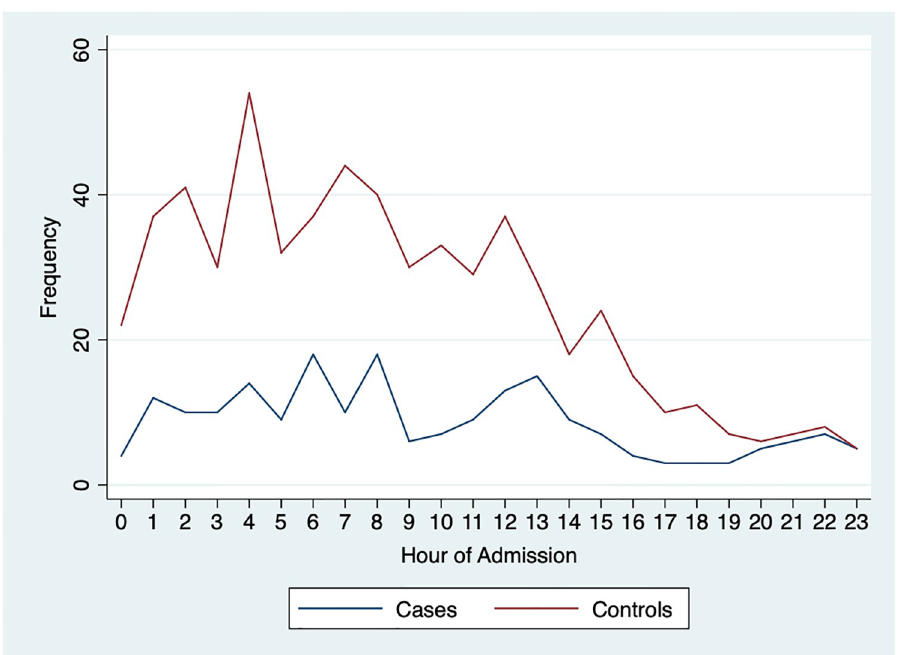
Fig 2. Overall admissions and neonatal deaths by time of NICU